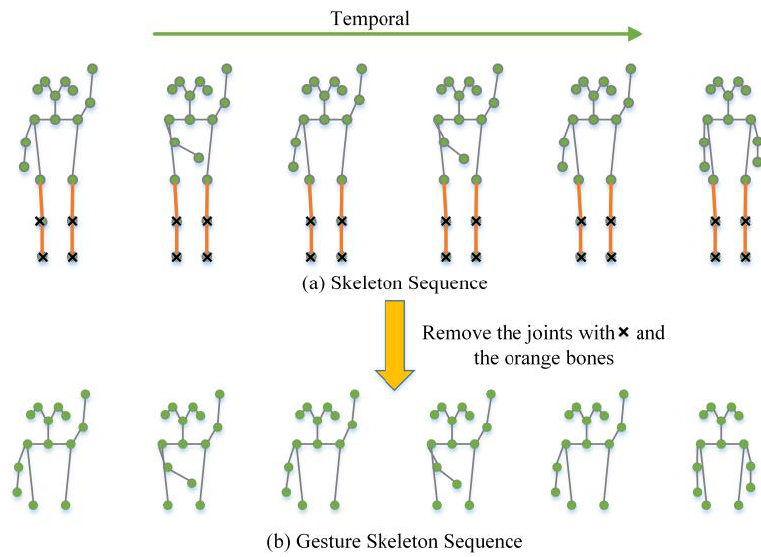
Figure 2. A skeleton sequence is transformed into a gesture skeleton